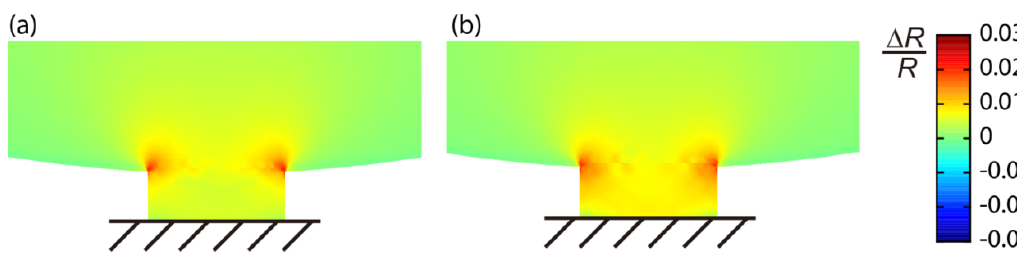
and 100 nm of Si 2